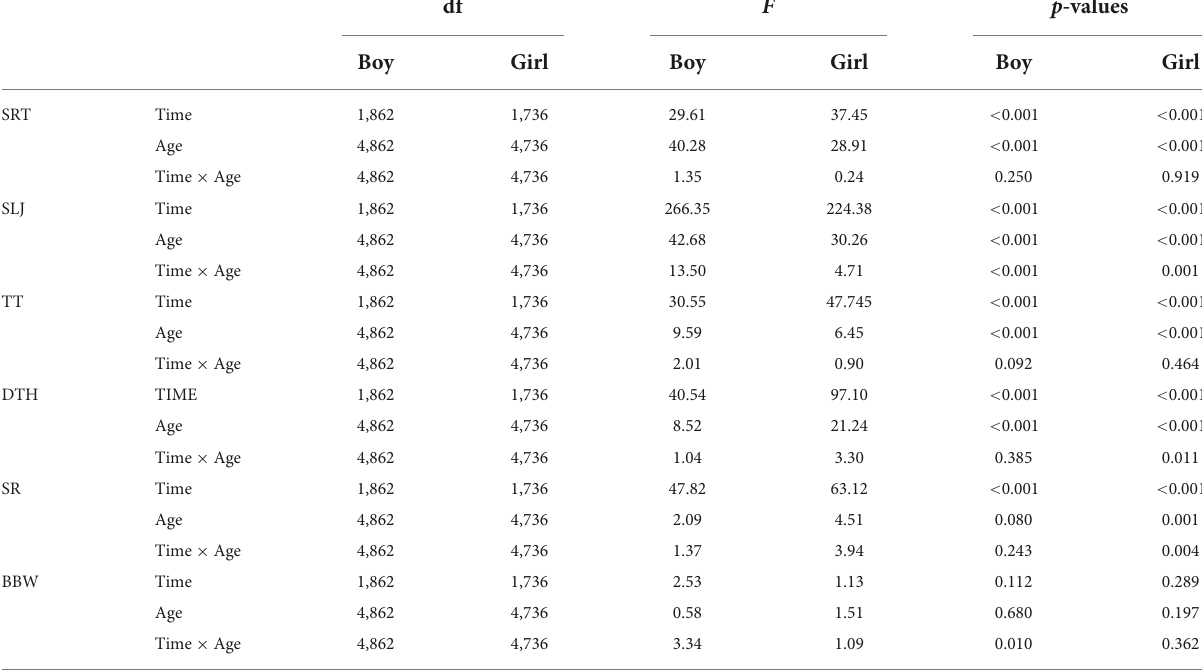
TABLE 3 All the within-subject and between-subject effects of all NPFM outcome variables.